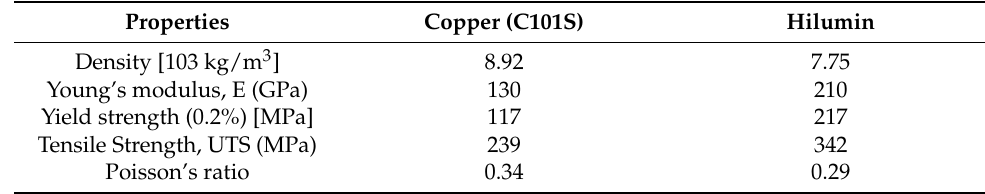
Figure 2. ( a ) Schematic of the tensile specimen, ( b ) stress–strain curve of the copper base material, and ( c ) stress–strain curve of the Hilumin steel base material. Table 2. Physical and mechanical properties of copper and Hilumin used in this study.